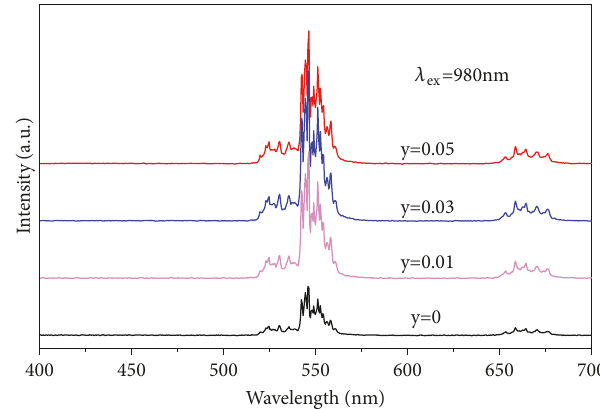
Figure 6: UCPL spectra of (Gd 0.91 phosphors.